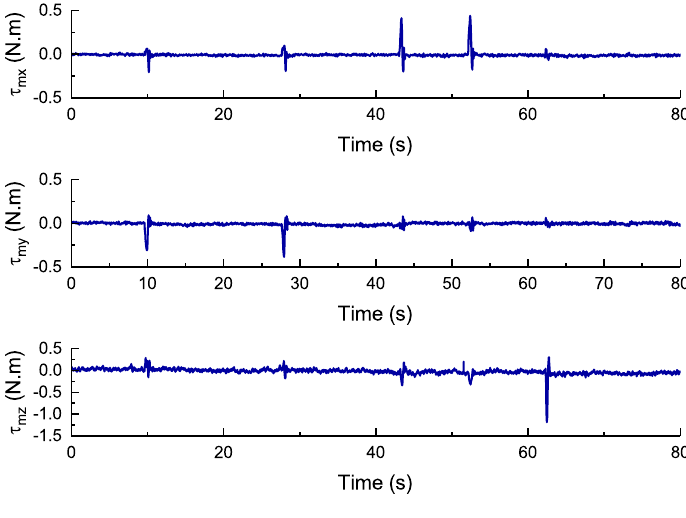
Figure 5. I&I control